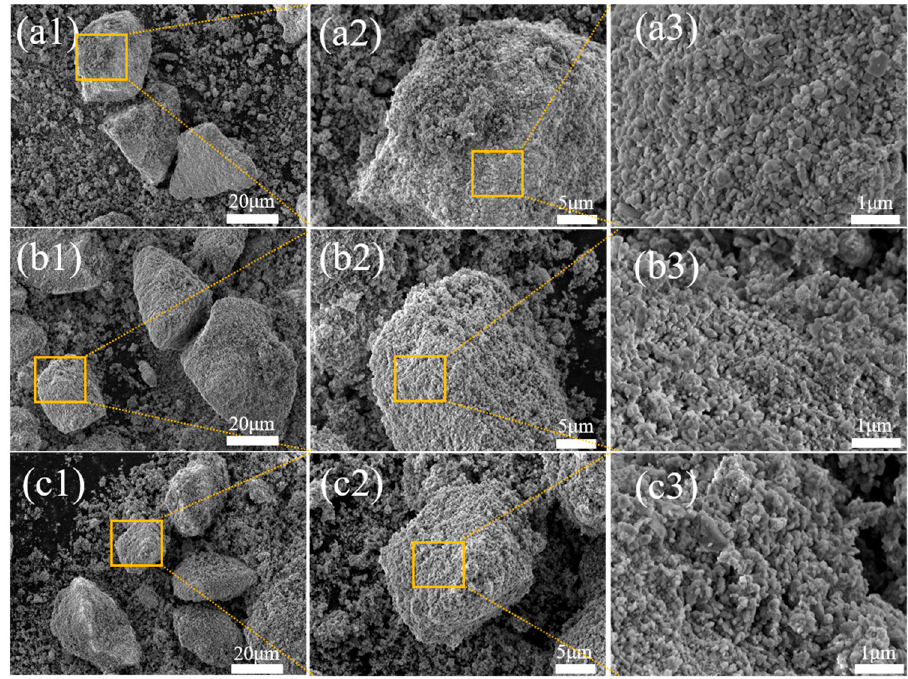
Figure 5 . SEM images of Co-coated Al 2 O 3 composite powders prepared by different Al 2 O 3 load: ( a1 – a3 )1 g/150 mL, ( b1 – b3 ) 1.5 g/150 mL and ( c1 – c3 ) 2 g/150 mL.